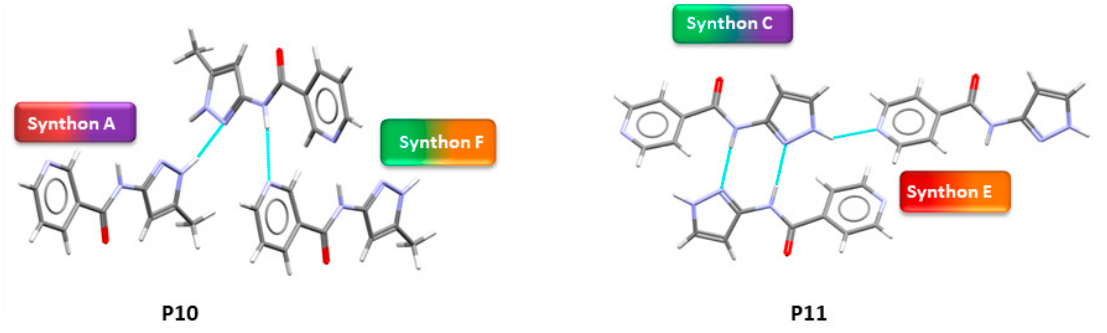
Figure 4. Crystal structures showing synthons (B + C) observed in P1, P2, P3, P4, P7 and (A + D) observed in P8 .